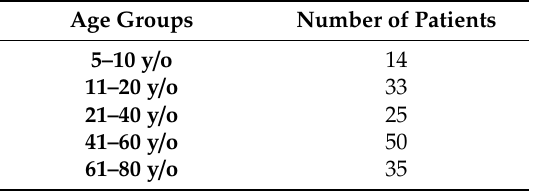
Table 3. Details of pre-pandemic population divided by age groups (years old, y/o)